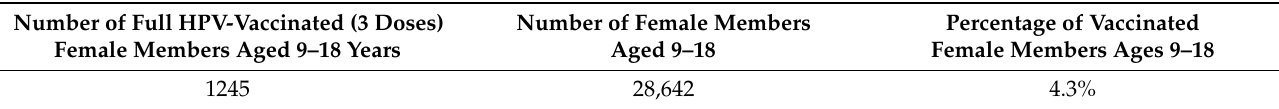
Table 8. Percentage of HPV-vaccinated female members aged 9–18 years—private health care (as of the end of 2021).